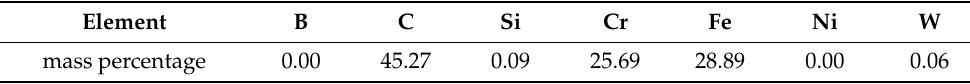
Table 4. Elemental composition of surface particles (at%).